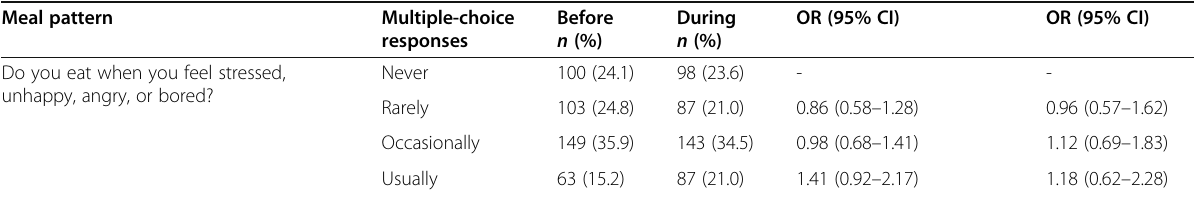
n number, OR odds ratio, CI confidence